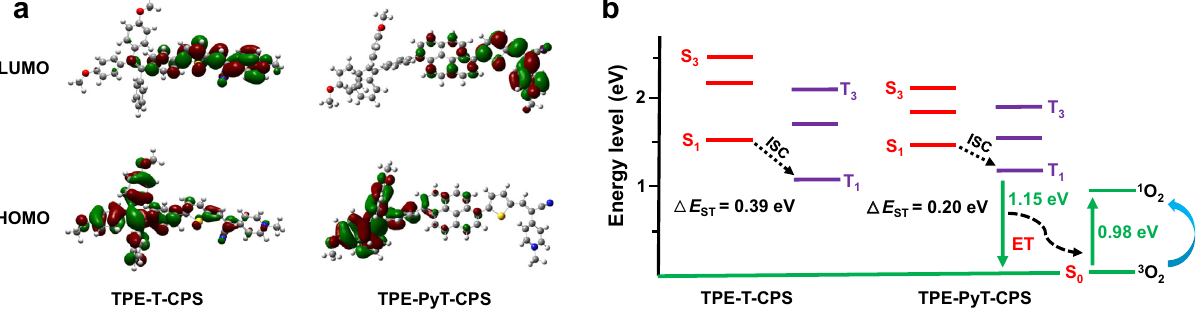
Fig. 3 Calculated frontier molecular orbitals and energy levels for TPE-T-CPS and TPE-PyT-CPS. a HOMO – LUMO electronic cloud distributions of TPE-T-CPS and TPE-PyT-CPS by DFT calculations. b Energy levels (S 1 – S 3 , T 1 – T 3 ) of TPE-T-CPS and TPE-PyT-CPS calculated by the vertical excitation of the optimized structures. ET: energy